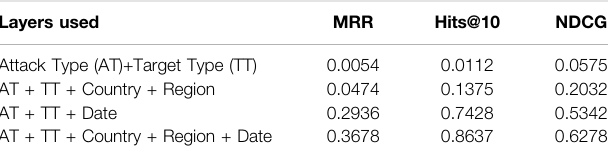
TABLE 4 | Results of graph-based methods on the event link prediction task. The representation learning in all cases was the DeepWalk algorithm. Layers